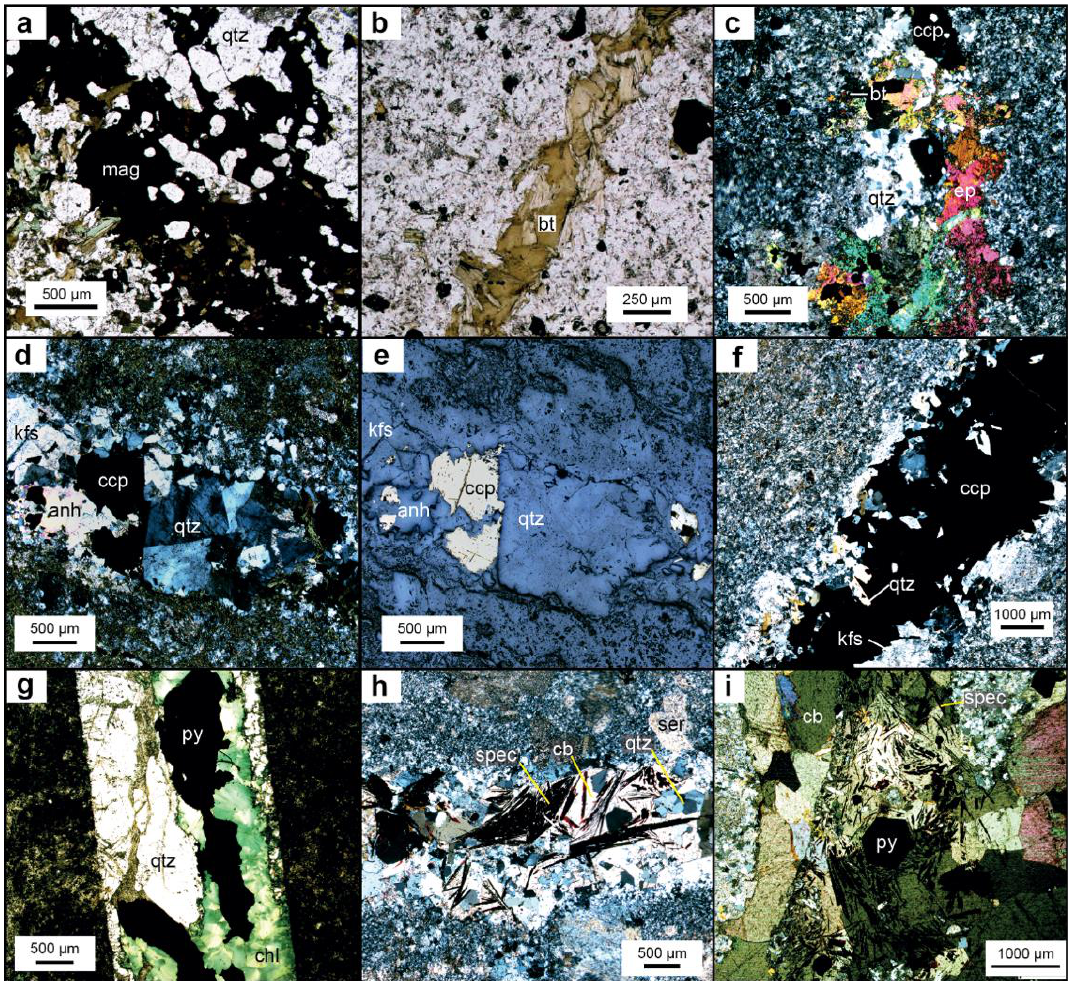
Figure 6. Photomicrographs of vein types from the core of Don Manuel. ( a ) Type 1 vein containing magnetite and quartz in an IPD (DM2AG45) in plane-polarized light. ( b ) Type 2 biotite vein in plane-polarized light in an IPD (DM2AG18). ( c ) Type 3 vein containing quartz + epidote + chalcopyrite with a weak biotite halo within an IPD (DM1AG17) in cross-polarized light. ( d ) Type 4a vein with quartz + K-feldspar + anhydrite + chalcopyrite in an IPD (DM3AG22) in cross-polarized light. ( e ) Type 4a vein previously shown in d, in reflected light. ( f ) Type 4b vein with chalcopyrite + quartz with a K-feldspar halo in an IPD in cross-polarized light. ( g ) Type 5 vein with chlorite + quartz + pyrite in an IPD in plane polarized light (DM2AG25). ( h ) Type 7 vein with quartz + calcite + specularite + pyrite with a sericite halo in an IPD in cross-polarized light. ( i ) Type 9 vein with carbonate + specularite + pyrite in a calc-silicate lithology (DM2AG13) in cross-polarized light. Mineral abbreviations: mag = magnetite, qtz = quartz, bt = biotite, ccp = chalcopyrite, ep = epidote, kfs = potassium feldspar, anh = anhydrite, py = pyrite, chl = chlorite, spec = specularite, ser = sericite, and cb =